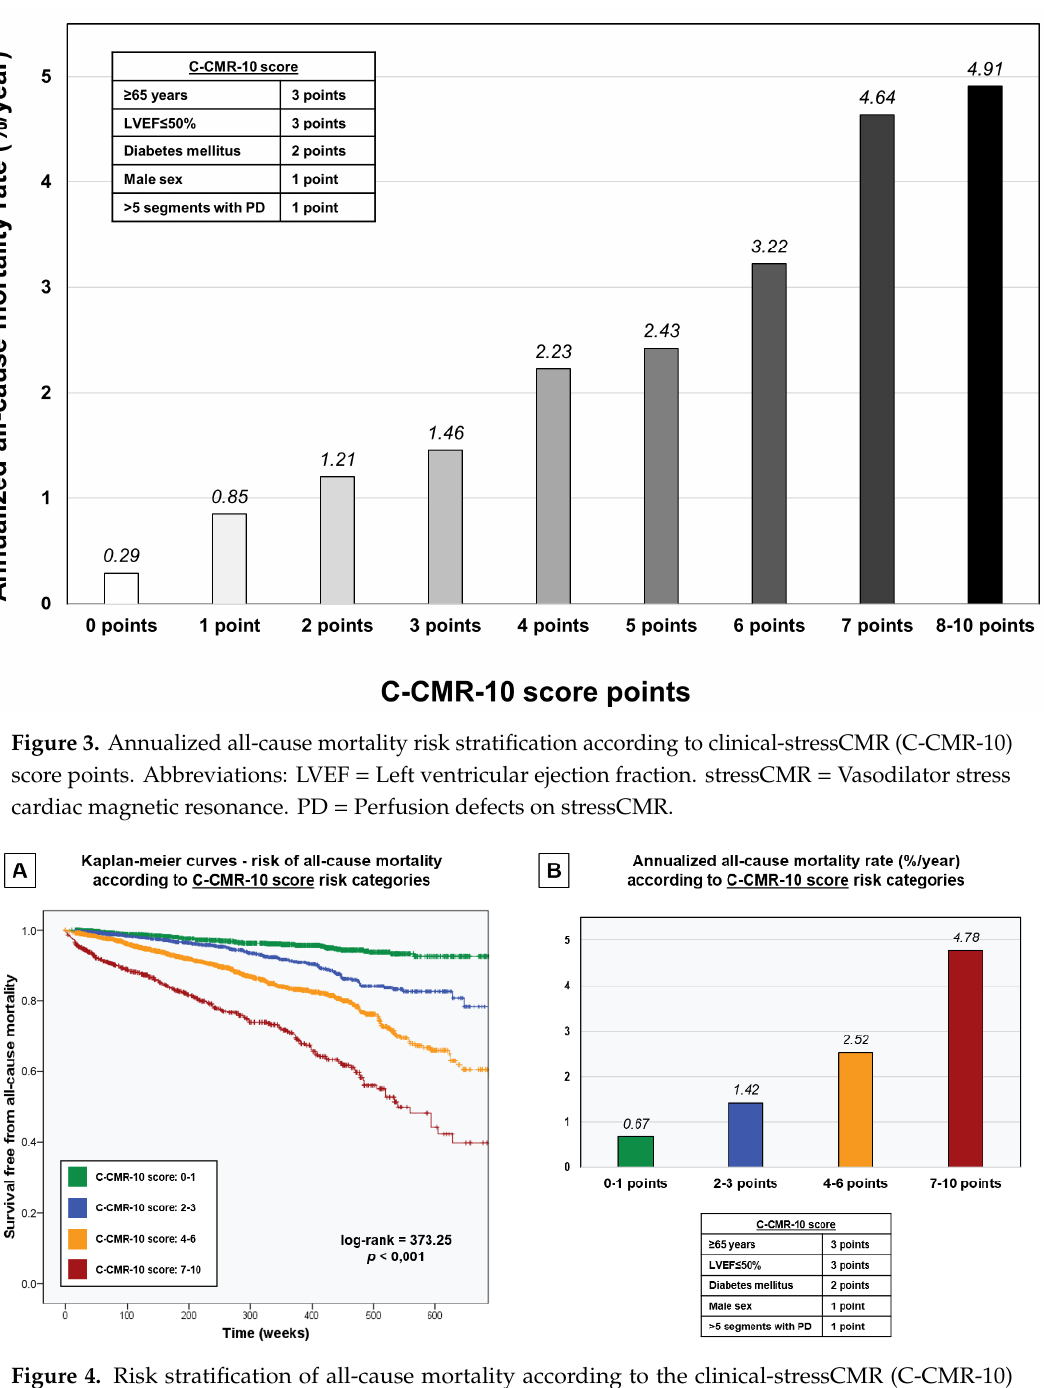
Figure 4. Risk stratification of all-cause mortality according to the clinical-stressCMR (C-CMR-10) score risk categories. ( A ) Kaplan–Meier curves to predict the risk of all-cause mortality during follow-up. ( B ) Annualized all-cause mortality stratification. Abbreviations: LVEF = Left ventricular ejection fraction. stressCMR = Vasodilator stress cardiac magnetic resonance. PD = Perfusion defects on stressCMR.